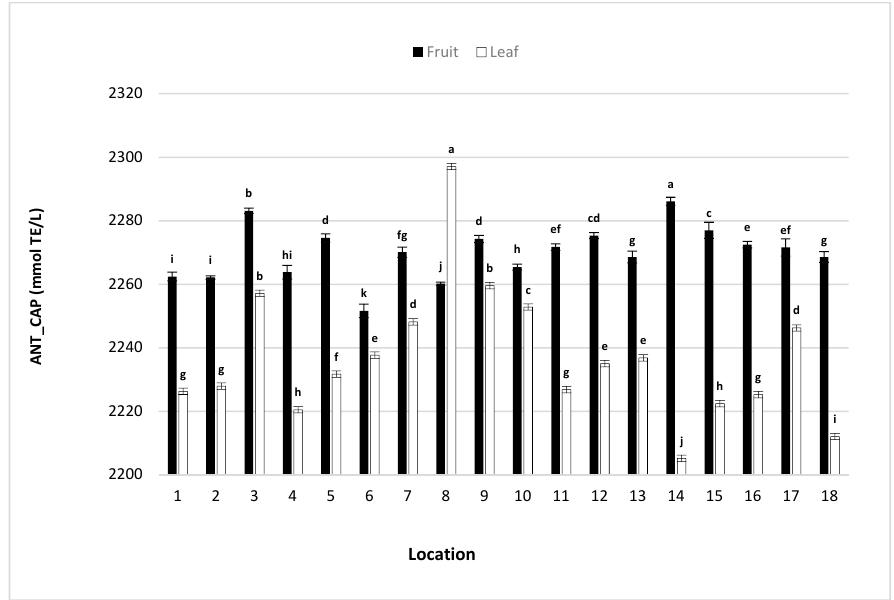
Figure 1. Antioxidant capacity (mmol TE/L) of strawberry tree fruit and leaves collected from different locations within the Adriatic coast. Different letters (a–k) indicate significant differences between means at p ≤ 0.0001.